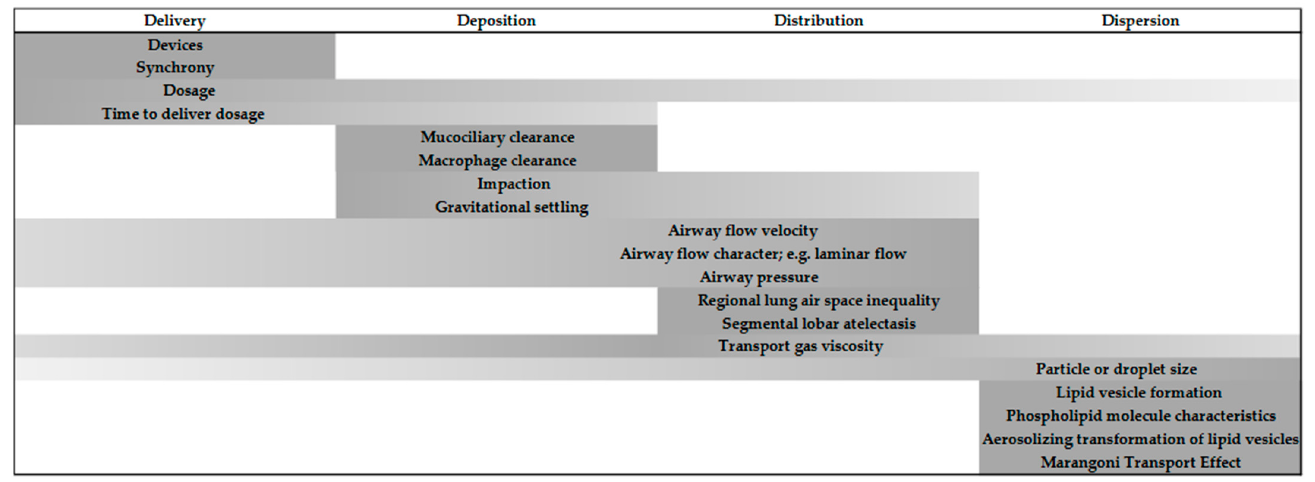
Figure 1. Dynamic processes for the movement of aerosolized surfactant within the human infant lung.